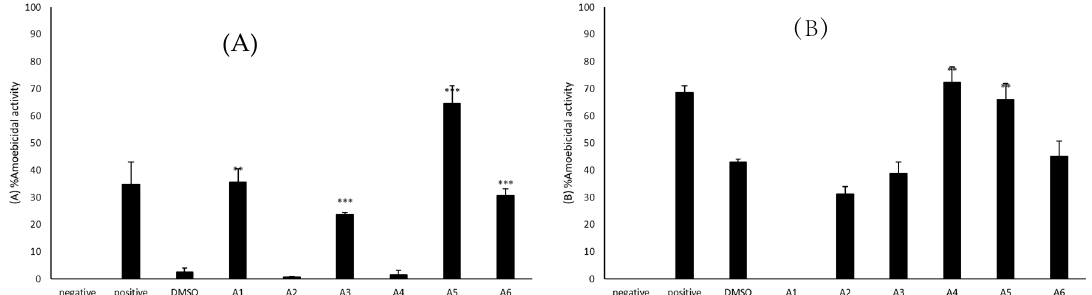
Figure 1. ( A ) The amoebicidal activities of azoles were determined. The results revealed that azoles caused a reduction in the number of viable B. mandrillaris cells. ( B ) The results revealed that azoles caused a reduction in the number of viable N. fowleri cells. The results are representative of at least three independent experiments performed in duplicates. The results are representative of at least three independent experiments performed in duplicates. The data are presented as the mean ± standard error (***: p < 0.001 using 2 sample t test; two tailed